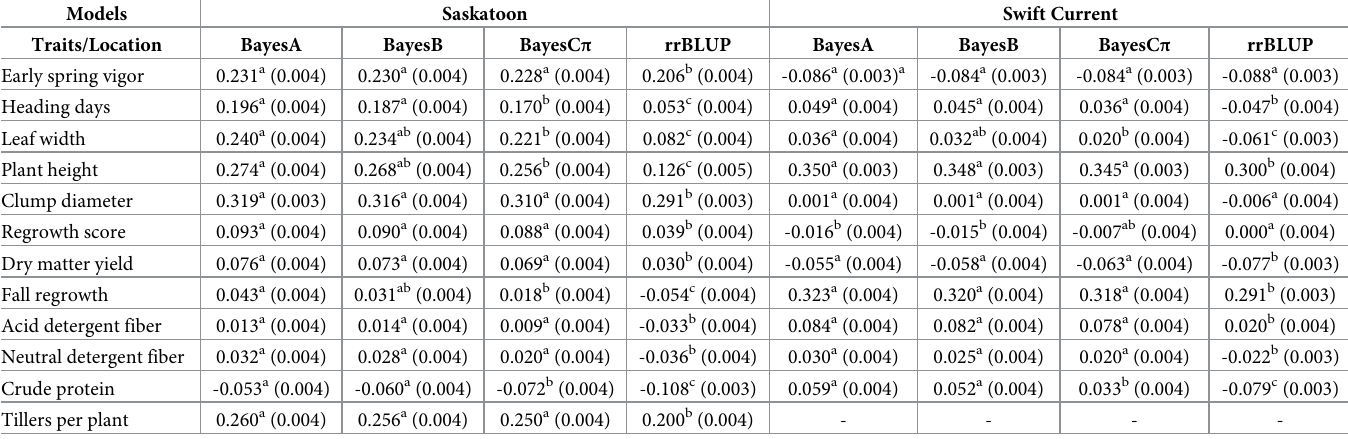
Table 6. Prediction accuracies of four genomic selection models at 50% missing level of SNPs information for agro-morphological and nutritive value traits of crested wheatgrass evaluated at Saskatoon and Swift Current, Canada.